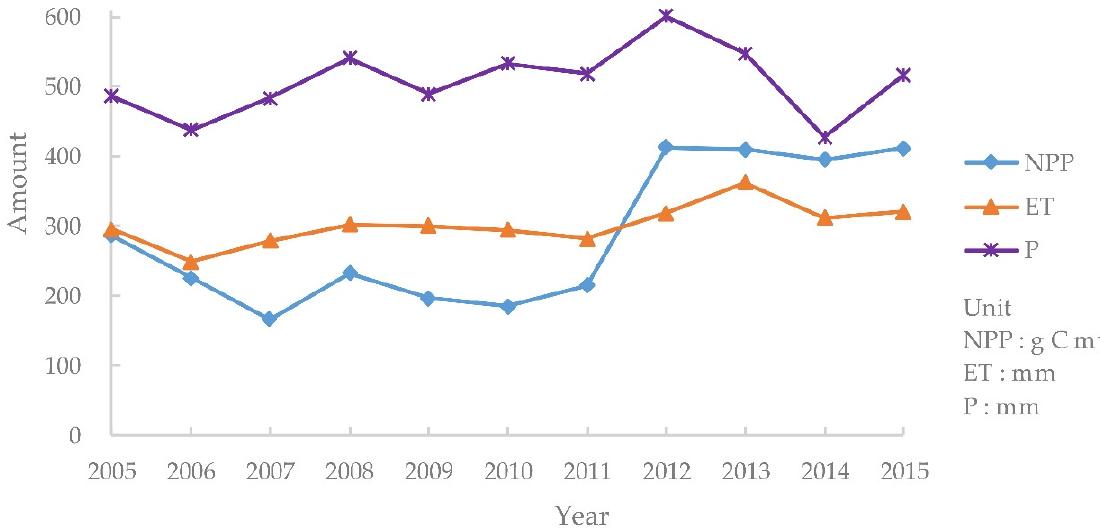
Figure 5. Temporal changes in the annual average net primary productivity (NPP), annual average evapotranspiration (ET), and annual average precipitation (P) in the Haihe River Basin from 2005 to 2015.